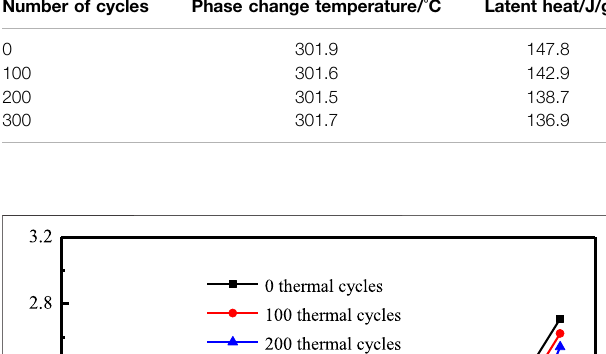
TABLE 8 | Changes in phase change temperature and latent heat of composites during 100 thermal cycles. Number of cycles Phase change temperature/ ° C